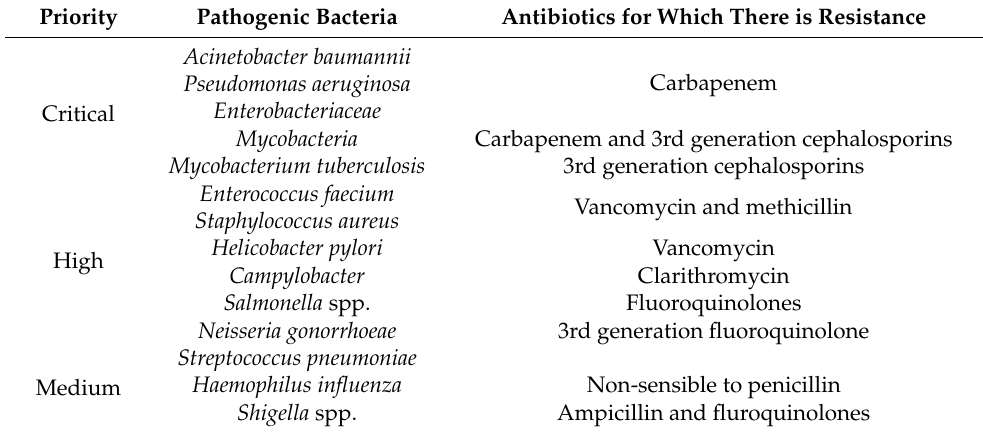
Table 1. The official list of pathogen bacteria with declared priority by the WHO. Adapted with permission from WHO (permission 387722)